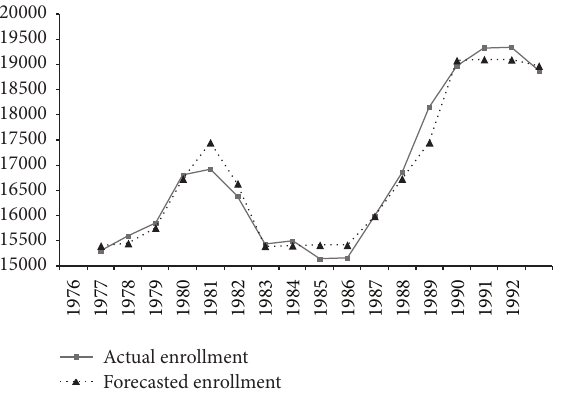
Figure 4: The actual and forecasted values of